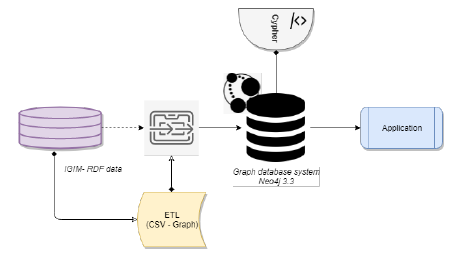
Figure 7: ETL process from the RDF model to Graph- based